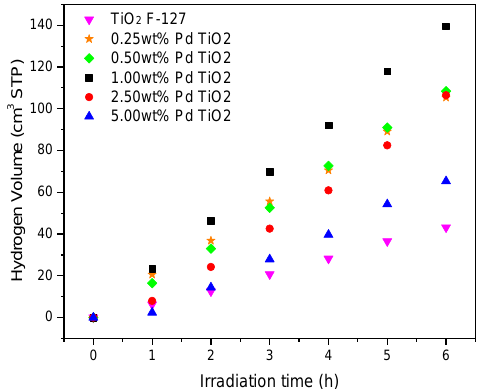
Figure 6. Cumulative hydrogen volume using Pd at different metal loadings (0.25, 1.50, 1.00, 2.50 and 5.00 wt%). Conditions: photocatalyst concentration 0.15 g/L, 2.0 v/v% ethanol, pH = 4 ± 0.05 and near-UV light. Standard deviation: ±3.0%.